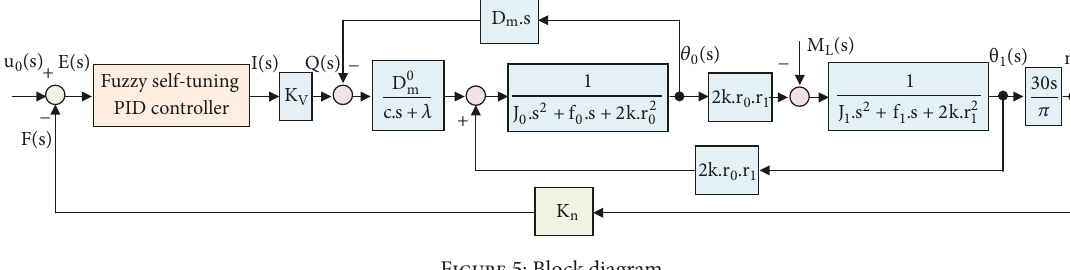
Figure 5: Block diagram.